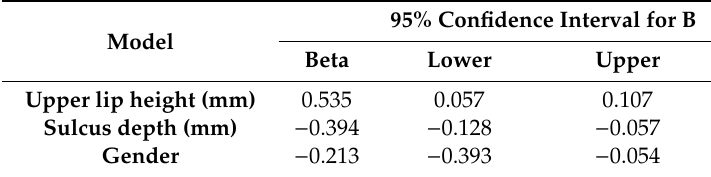
Table 5. Stepwise linear logistic regression analysis to predict the ULHL